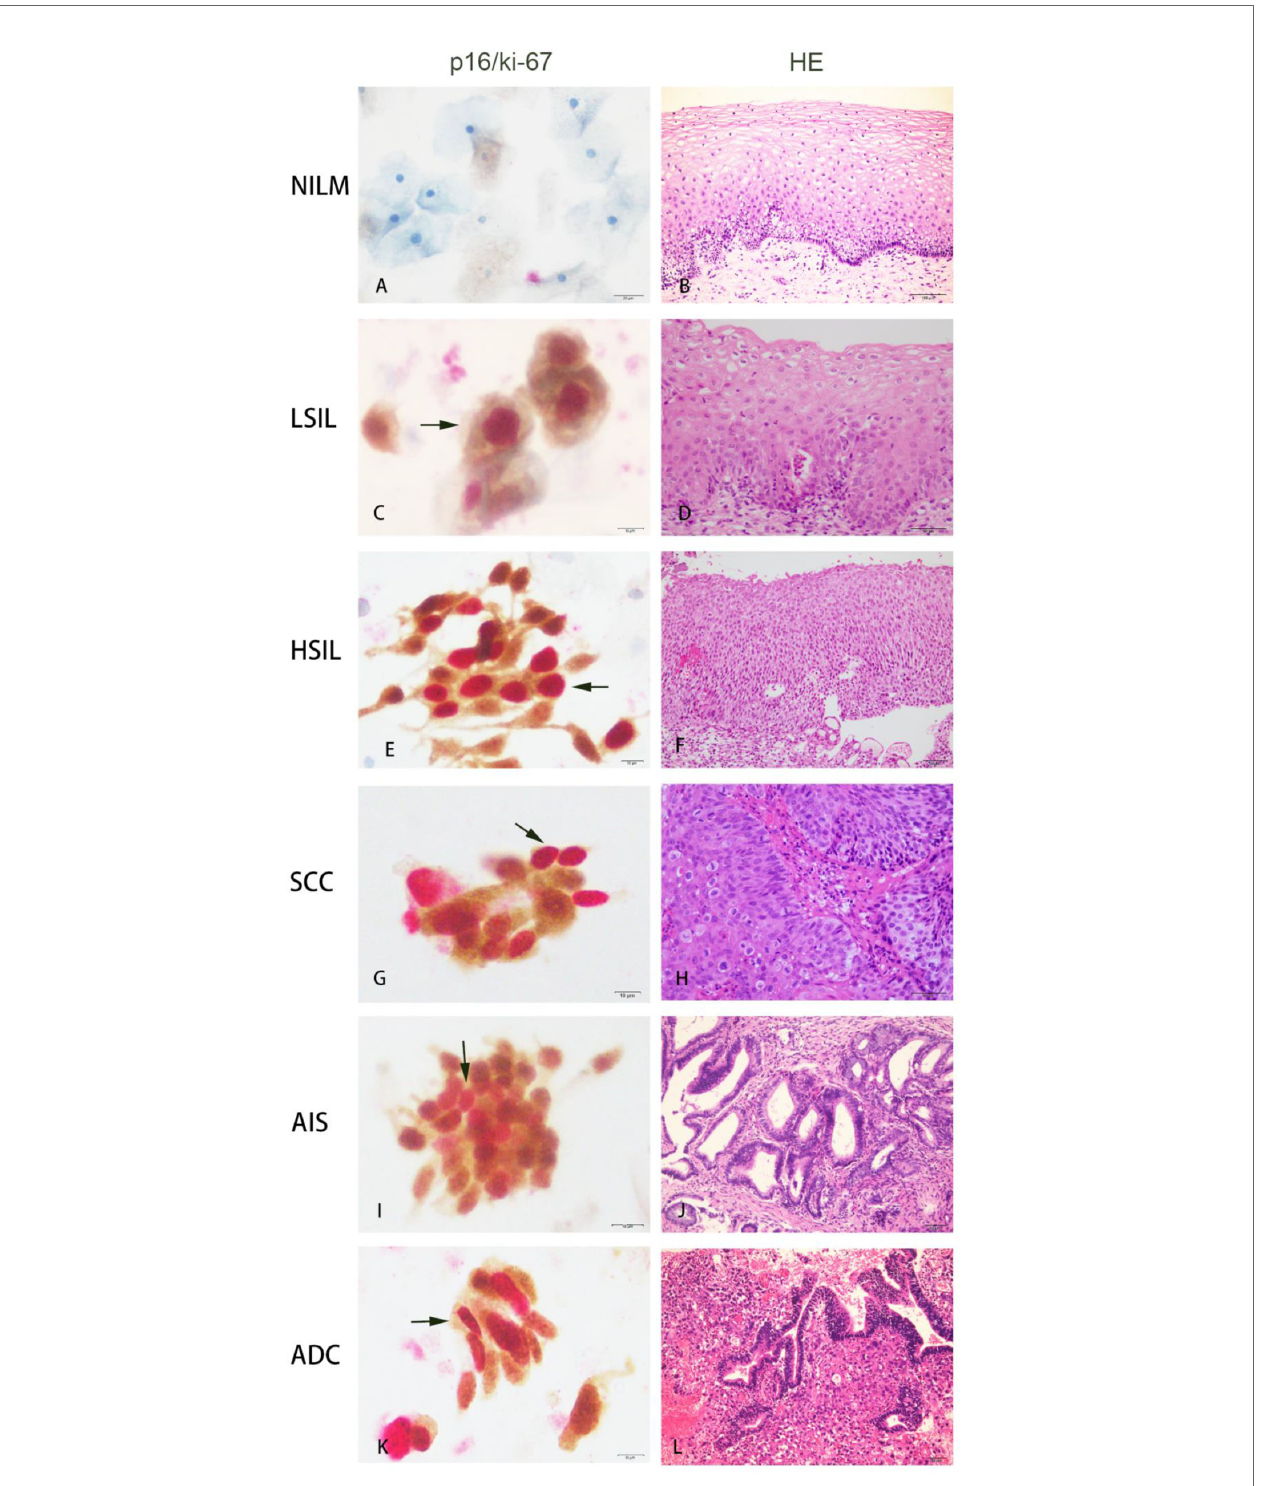
FIGURE 2 | Co-expression of p16/ki-67 in cytological specimens detected by p16/ki-67 dual-staining (DS) and haematoxylin and esion (HE) staining in histology of the same cases. The positive p16/ki-67 dual-staining cells (dark arrow) are characterized by a brown cytoplasmic signal for p16 overexpression and a dark red nuclear signal for p16/ki-67 co-expression in the same cells. NILM, negative for intraepithelial lesions or malignancy; LSIL, low-grade squamous intraepithelial lesion; HSIL, high-grade squamous intraepithelial lesion; SCC, squamous cell carcinoma; AIS, adenocarcinoma in situ ; ADC, adenocarcinoma.